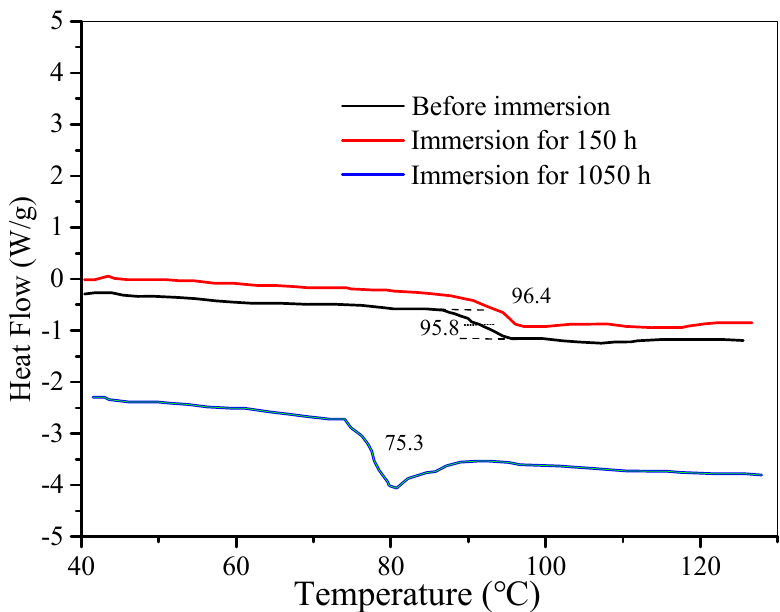
Figure 3. A comparison of the water uptake for the coatings aged in a 5 wt.% NaCl solution obtained via gravimetry.